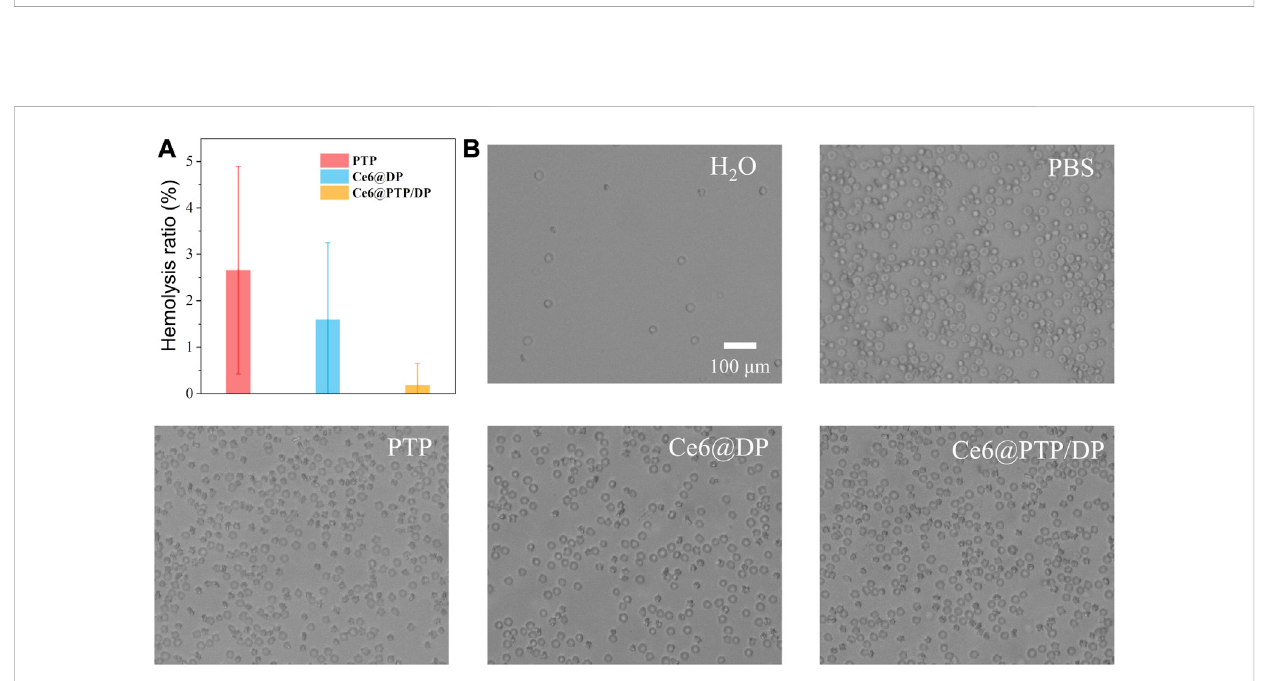
FIGURE 7 (A) The hemolysis ratio induced by PTP, Ce6@DP, Ce6@PTP/DP micelles incubated at 37 ° C for 6 h in dark. Data represent the mean ± s.d (n = 3). (B) Opticalmicroscopicobservation